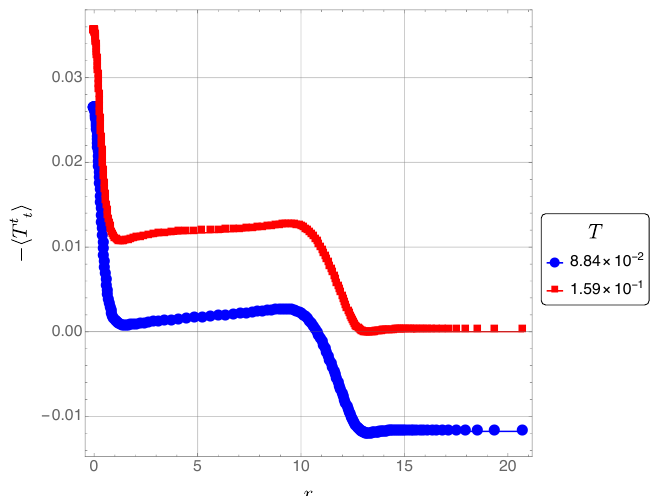
Figure 19 . Energy density as a function of the boundary proper distance r for the new black hole solutions, computed with (cid:22) = 4, (cid:23) = 3 (same parameters as in (cid:12)gure 17). The temperatures used are indicated in the legend above. (The upper curve has T = 1 = (2 (cid:25) ).) There are four distinct regimes, corresponding to di(cid:11)erent radial dependences, which we do not yet